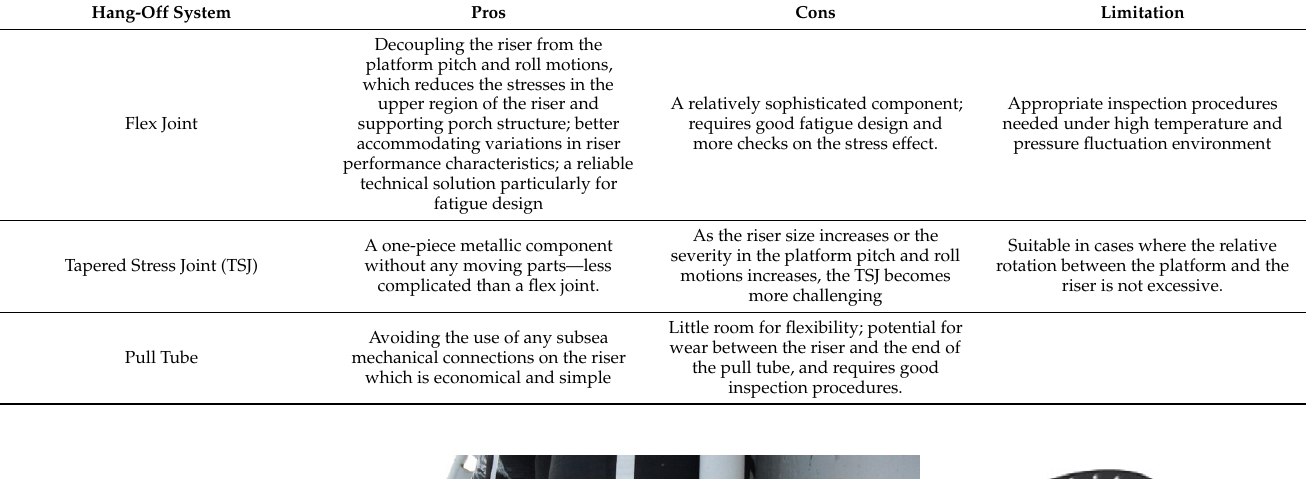
Table 6. Pros and Cons of various hang-off systems.